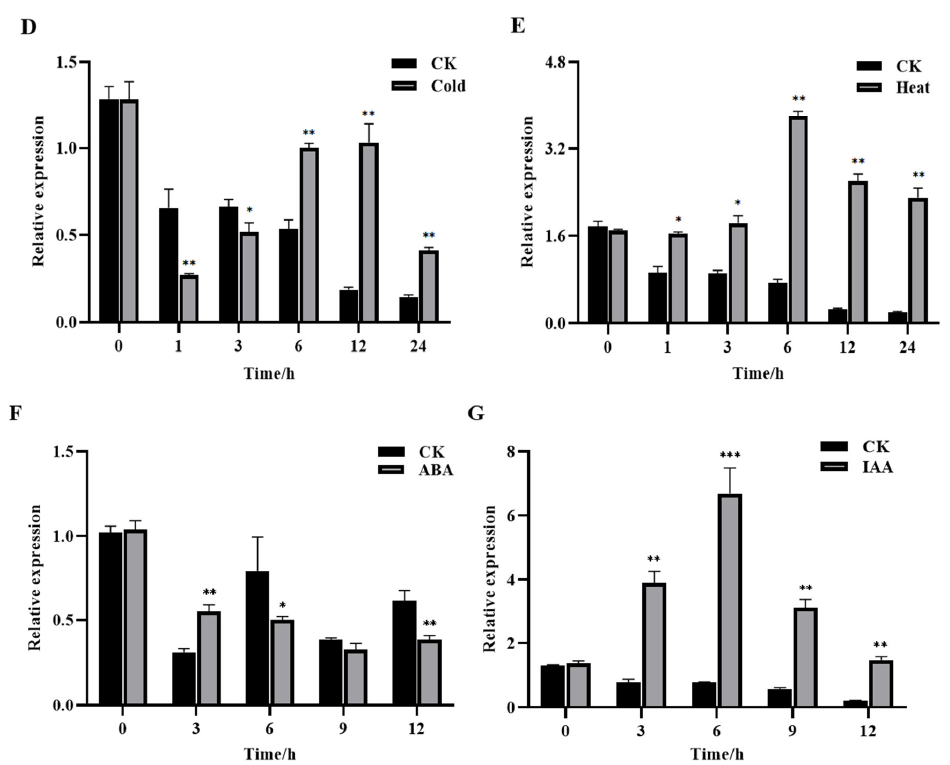
Figure 3. Transcript levels of the GhROP3 gene. ( A ) Transcript levels of GhROP3 in cotton roots, stems, leaves, and cotyledons. Transcript levels of GhROP3 in leaves under abiotic stress treatments, including treatments with polyethyleneglycol (PEG) ( B ), NaCl ( C ), cold ( D ), heat ( E ), abscisic acid (ABA) ( F ), and auxin (IAA) ( G ). Statistical analyses were performed using the Student t test. Asterisks indicate a significant difference compared with the control. *, p < 0.05; **, p < 0.01; ***, p < 0.001.